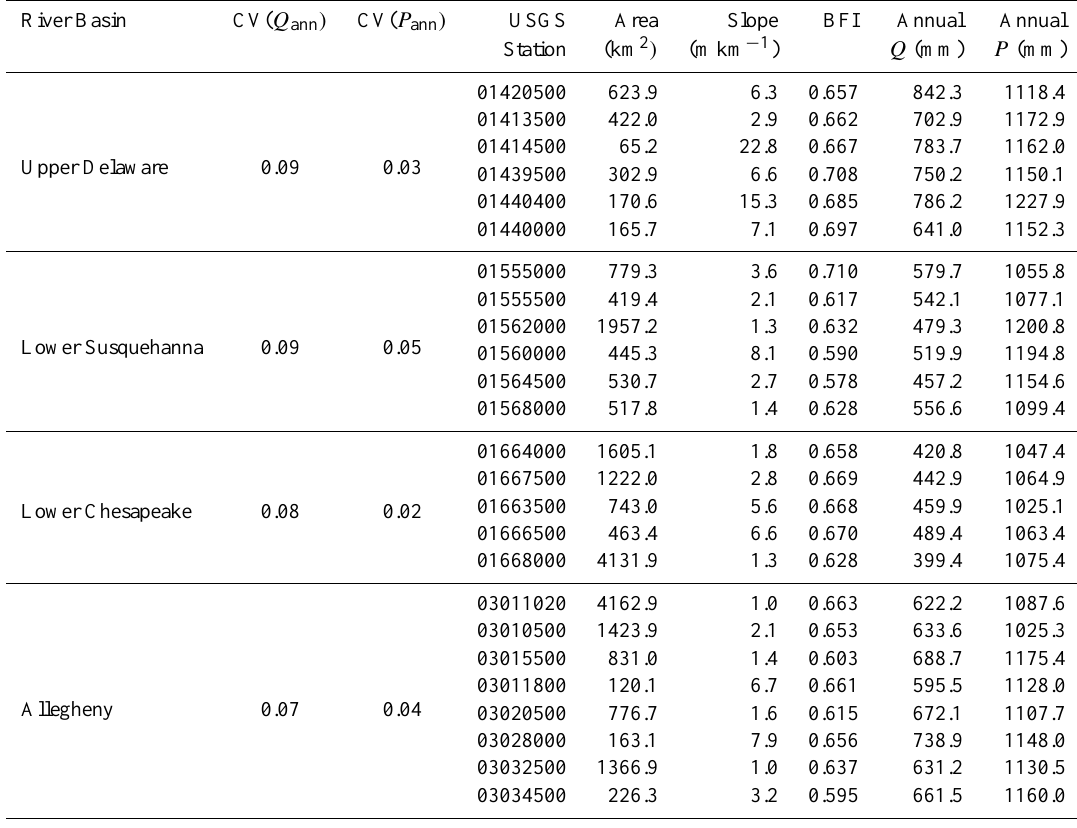
Table 1. Details of the 25 catchments within the four river basins.